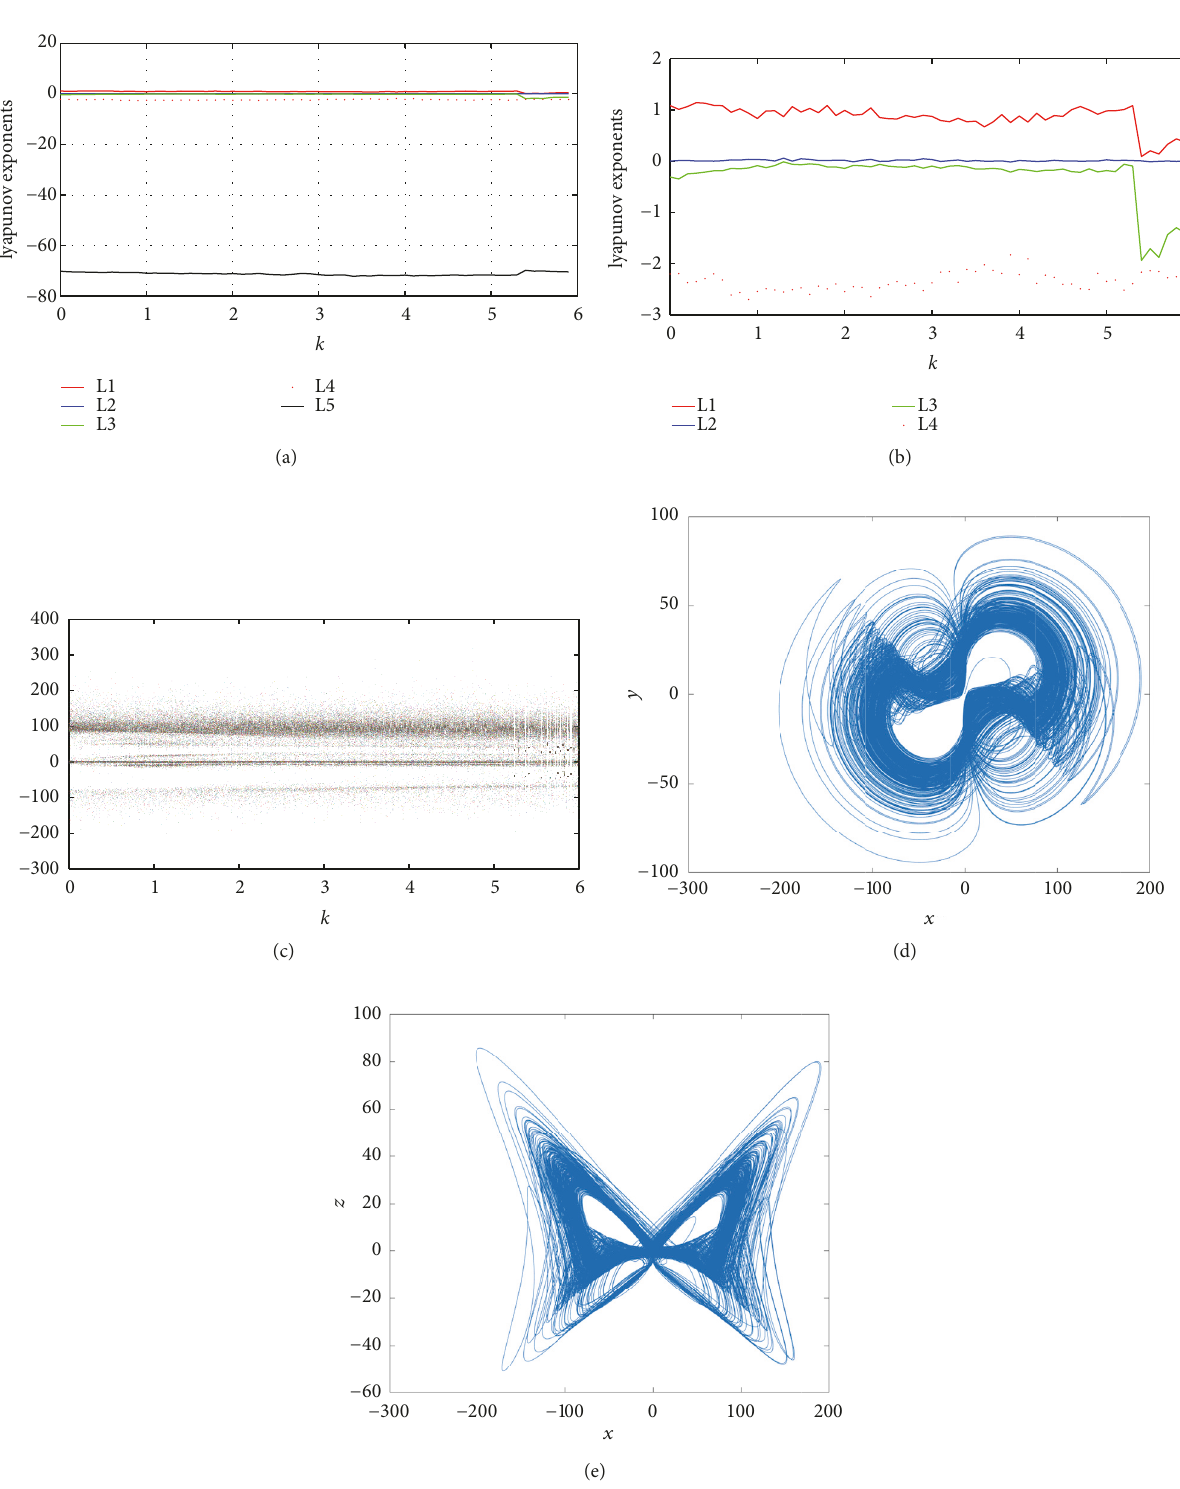
Figure 1: Lyapunov exponents versus the parameter 𝑘 : (a) the full five exponents, (b) Lyapunov exponents L 1 - L 4 of System (6), (c) the bifurcation diagram of 𝑥 vs. 𝑘 for System (6) when 𝑚 = 0.1 , 𝑛 = 0.01 , and 𝑔 = 0.3 . (d)-(e) The phase portraits 𝑥 - 𝑦 and 𝑥 - 𝑧 for System (6) when 𝑘 = 0.02 , 𝑚 = 0.1 , 𝑛 = 0.01 , and 𝑔 = 0.3